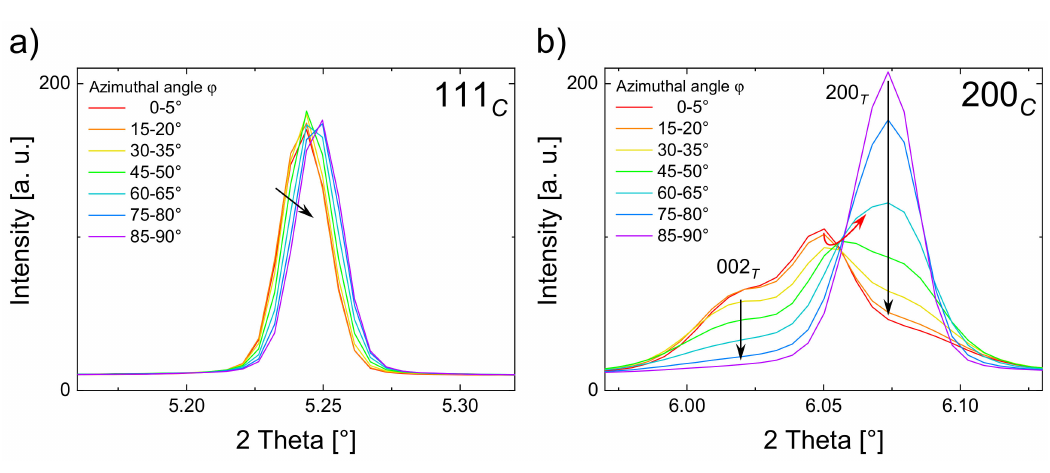
Figure 4. Orientation-dependent di ff raction pattern of the 111 C reflection ( a ) and the 200 C reflection ( b ) at di ff erent azimuthal angles ϕ in the applied field state at 5 kV /